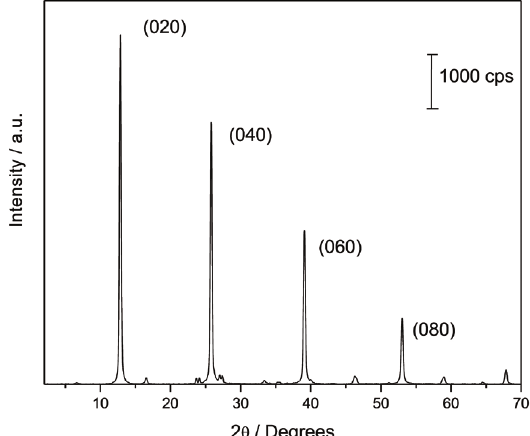
Figure 1. Diffractogram of sol-gel WO